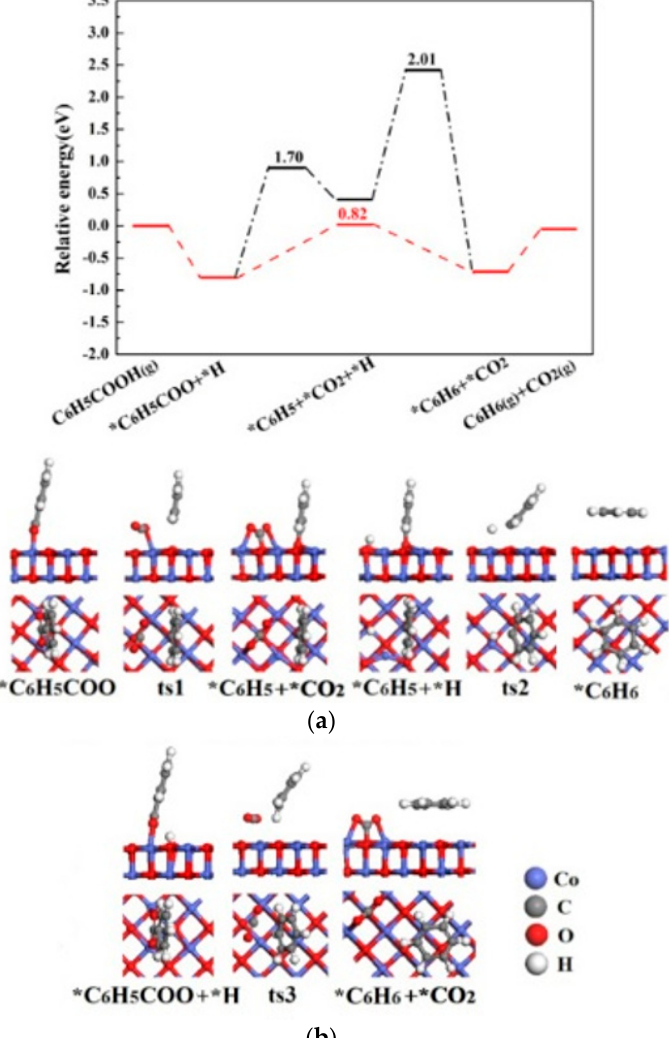
Figure 5. The potential energy diagrams (Red line: C 6 H 5 COOH(g) → *C 6 H 5 COO + *H → *CO 2 + *C 6 H 6 → CO 2 (g) + C 6 H 6 (g); Black line:C 6 H 5 COOH(g) → *C 6 H 5 COO + *H → *C 6 H 5 + *CO 2 + *H → *CO 2 + *C 6 H 6 → CO 2 (g) + C 6 H 6 (g)) and corresponding IS, TS, and FS geometrical structures of C 6 H 5 COOH catalytic pyrolysis on CoO(100) surface ( a ) related to black line; ( b ) related to red line.